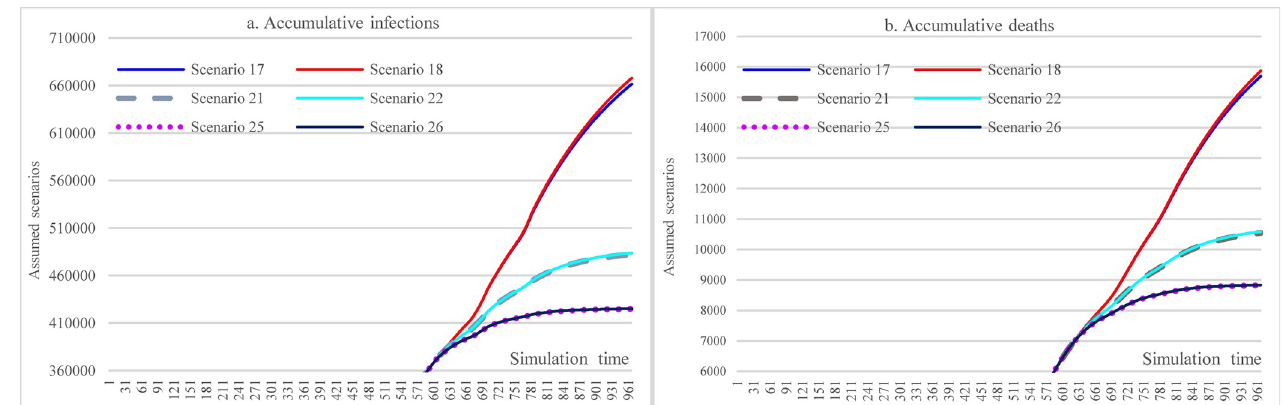
Fig 11. Impacts of increasing stringency of social distancing measures in scenario analysis.